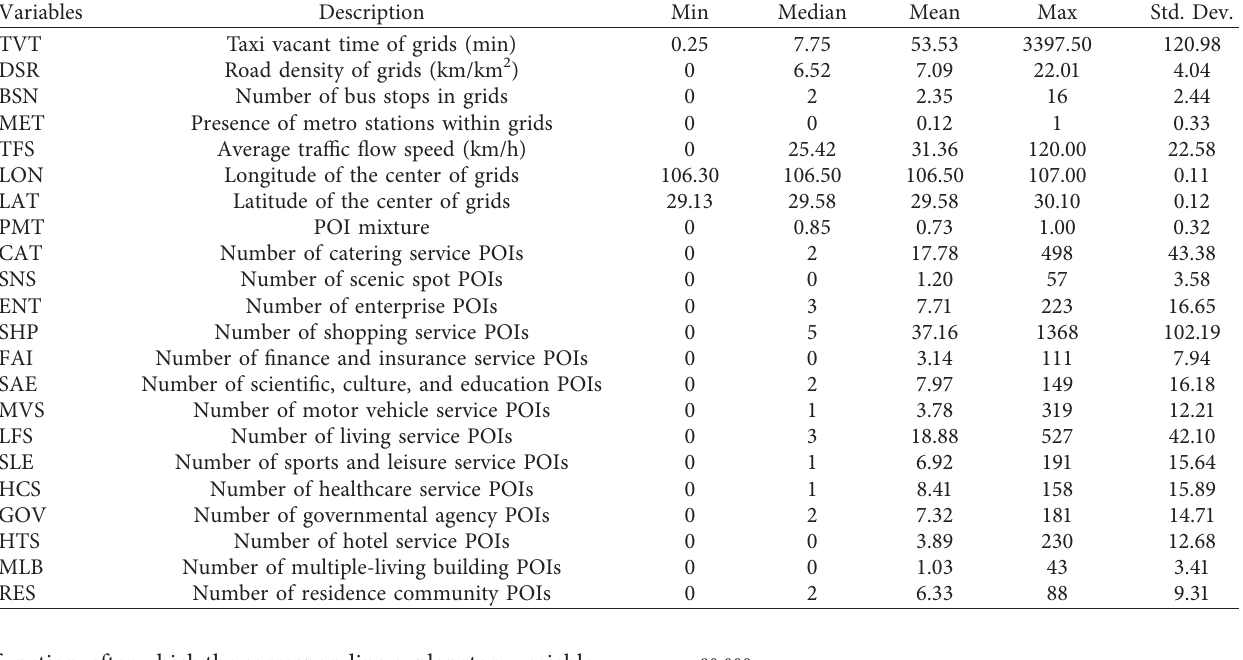
Table 1: Descriptive statistics of the variables.